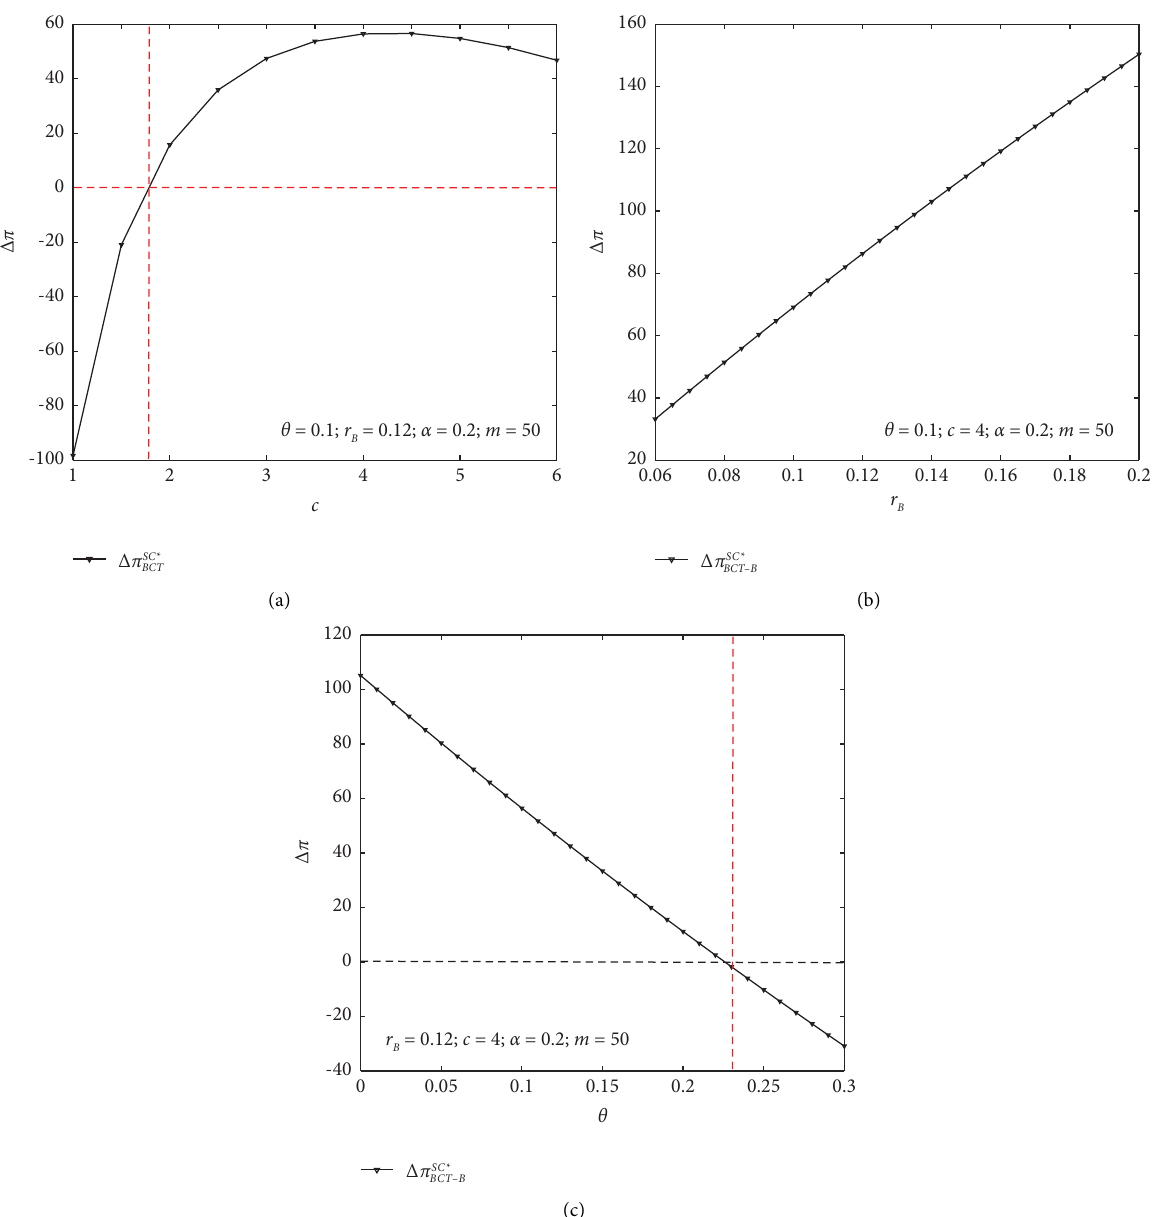
Figure 2: Te impact of fnancing costs on the efciency of diferent fnancing